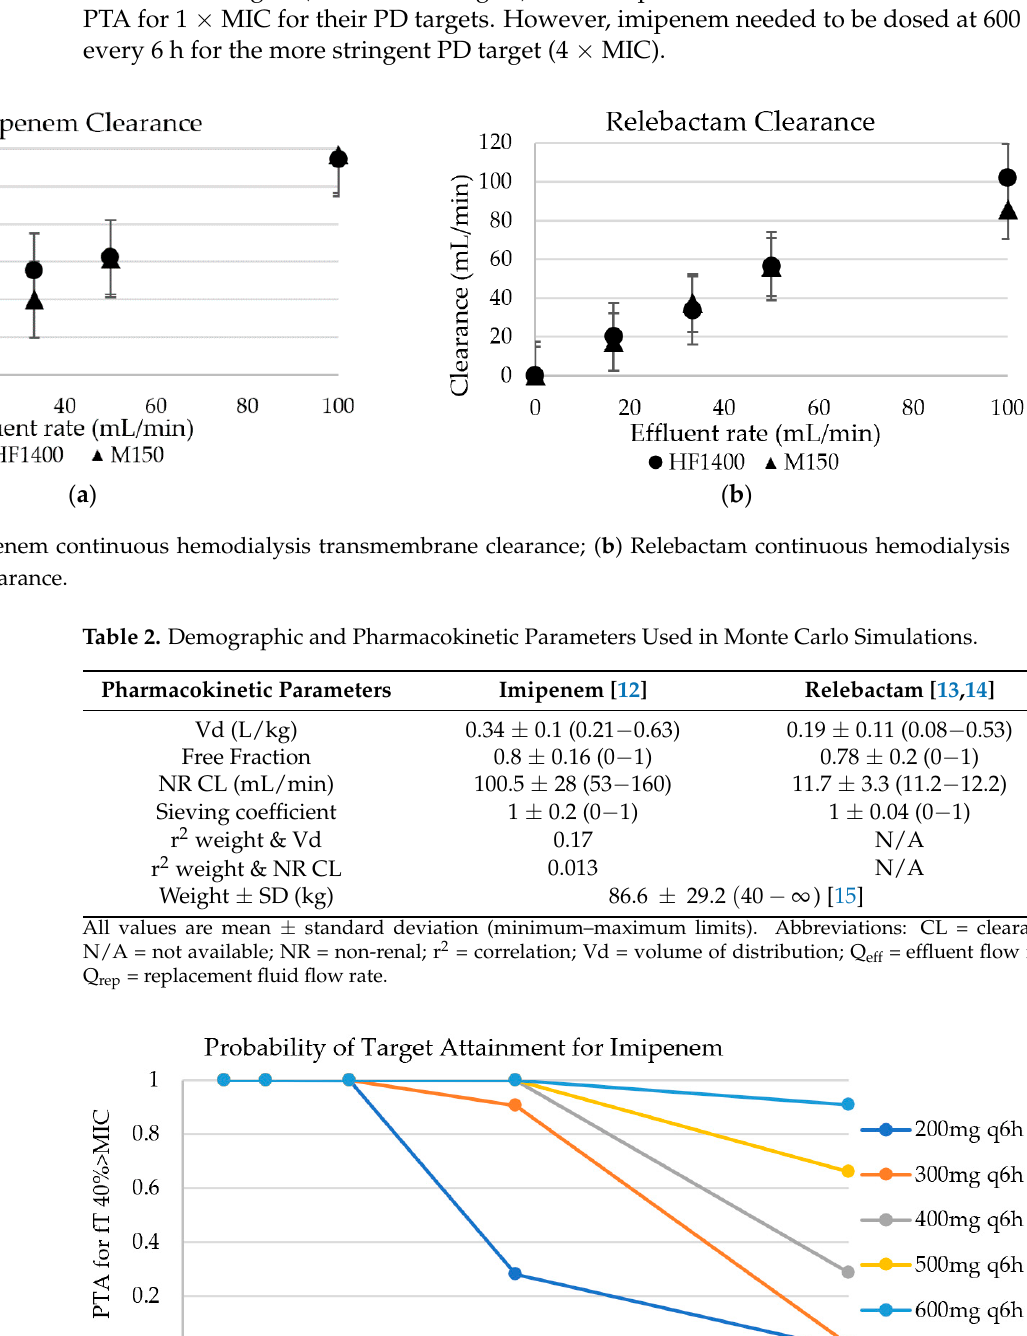
Figure 1. ( a ) Imipenem continuous hemofiltration transmembrane clearance. ( b ) Relebactam continuous hemofiltration transmembrane clearance.